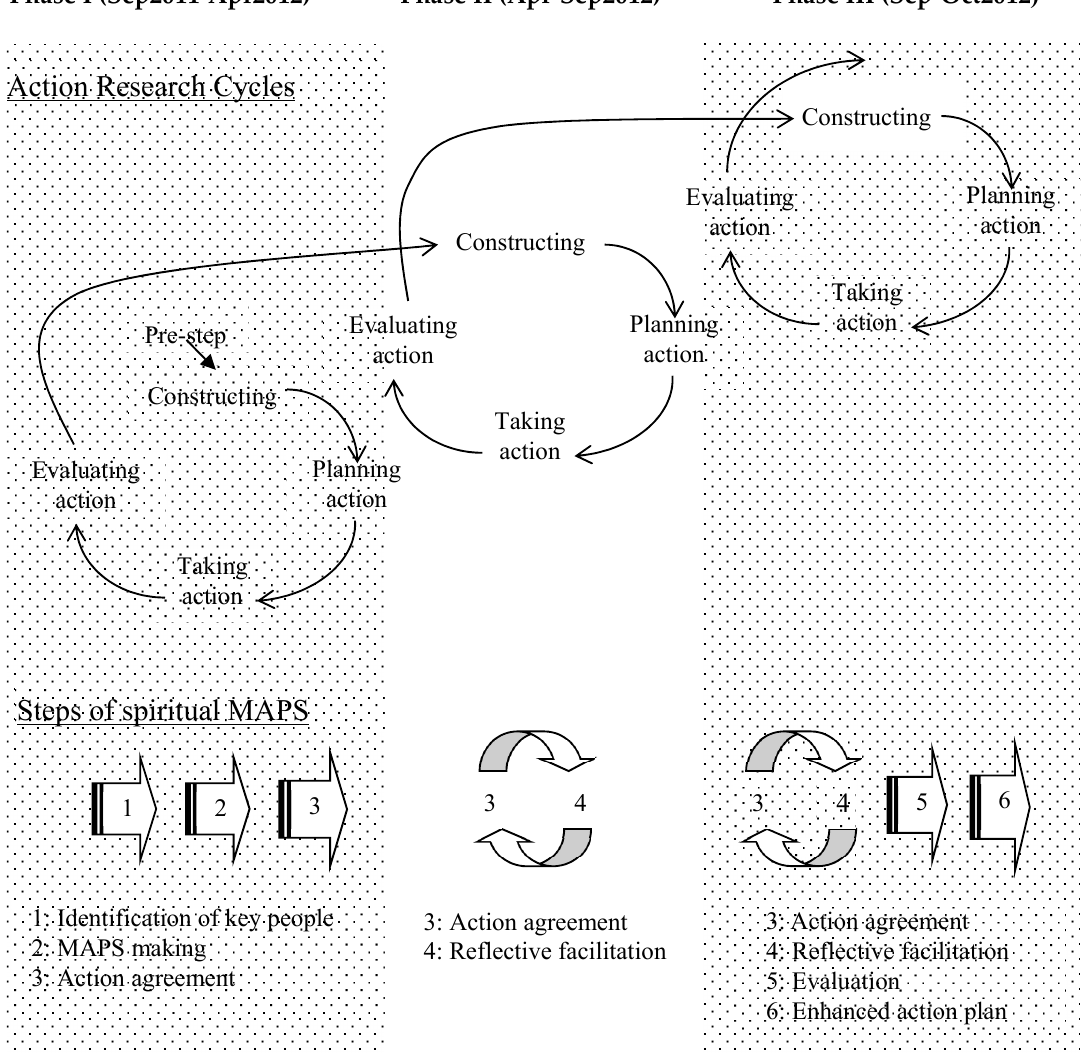
Figure 2. The combined action research and spiritual mapping framework.